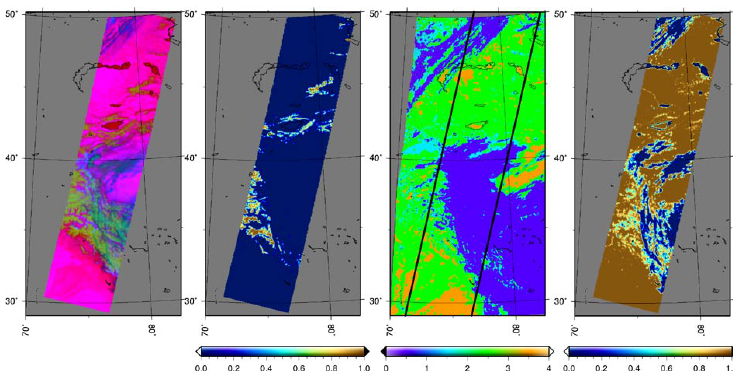
Figure 14. Himalayan mountains. AATSR: 18 April 2006, 05 h 17'59'', orbit number 21601. MODIS: 18 April 2006, 05 h 20'. Left panel is the false color composite (red is 11µm BT, green is 550nm reflectance, blue is 1.6µm reflectance) of initial AATSR scene; second left panel is the clear snow mask of AATSR scene (0 – not snow, 1 – clear snow) achieved with presented method; third left panel is MODIS cloud mask: 1 – cloudy, 2 – probably cloudy, 3 – probably clear, 4 – clear; right panel is operational AATSR cloud mask from level-1b product: 0 – cloudy, 1 – clear.